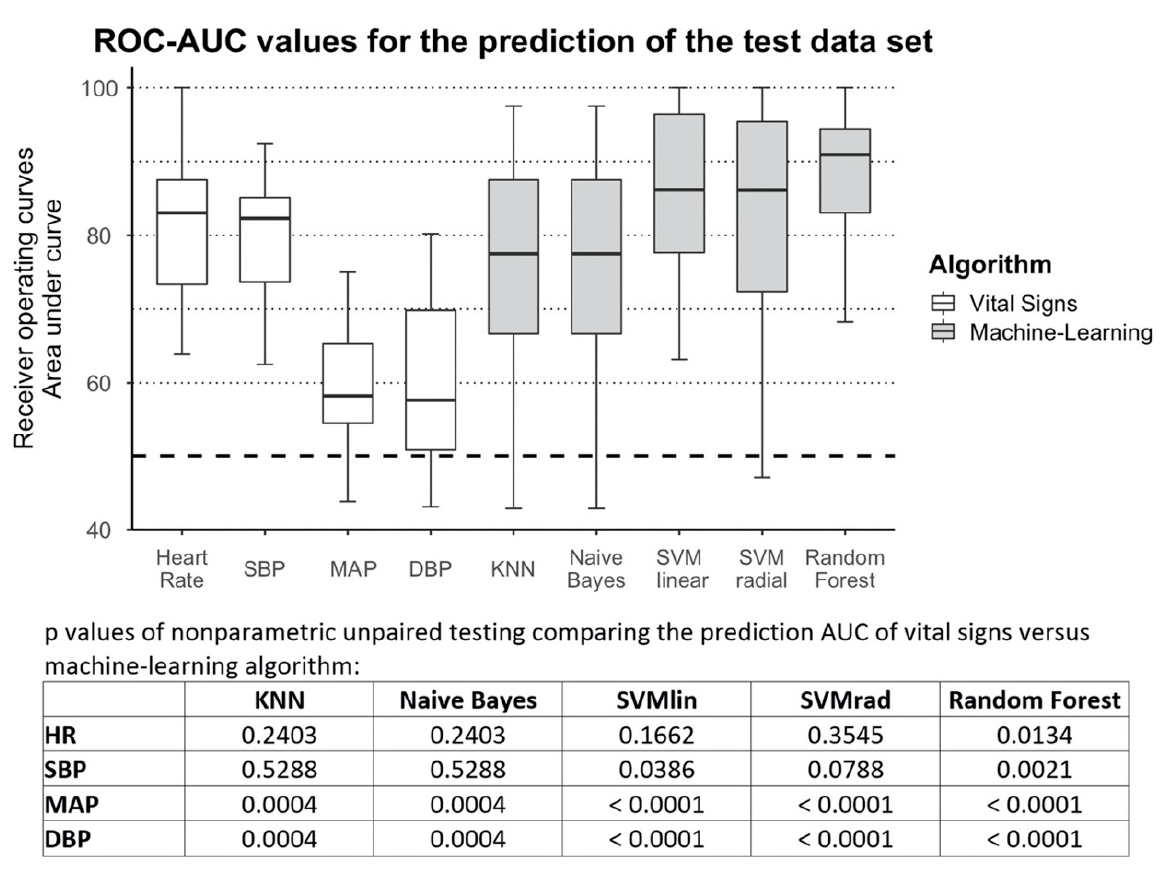
Figure 7. Machine-learning prediction results and statistical comparison: boxplots of the area under the curve (ROC-AUC) of the vital signs and generated models when predicting the stroke volume decrease measured by transthoracic echocardiography (SV-TTE) in the test dataset. Results of unpaired non-parametric testing for comparing results are displayed in the table below. DBP: diastolic blood pressure; HR: heart rate; KNN: K-nearest neighbours; MAP: mean arterial pressure; SBP: systolic blood pressure SVMlin: Support Vector Machines using a linear kernel; SVMrad Support Vector Machines using a radial